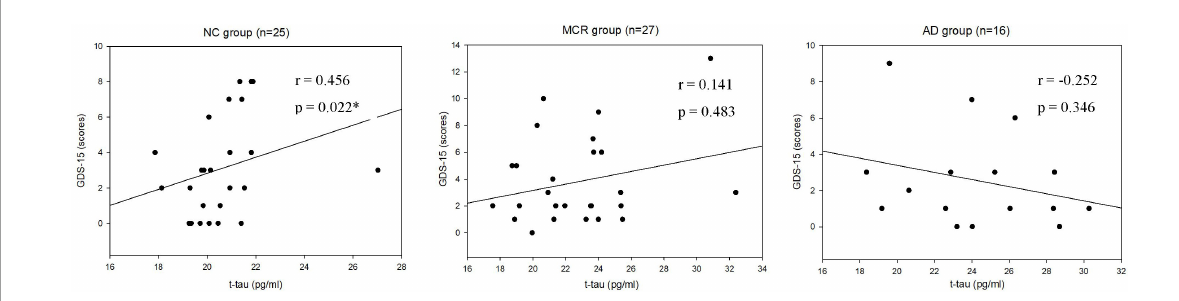
FIGURE2 Scatterplots of the associations between Geriatric Depression Scale-15 (GDS-15) scores and plasma t-tau levels (pg/ml) in the three groups. NC, normal cognition; MCR, Motoric Cognitive Risk syndrome; AD, Alzheimer’s disease; t-tau, total tau; GDS-15, Geriatric Depression Scale-15; * p <